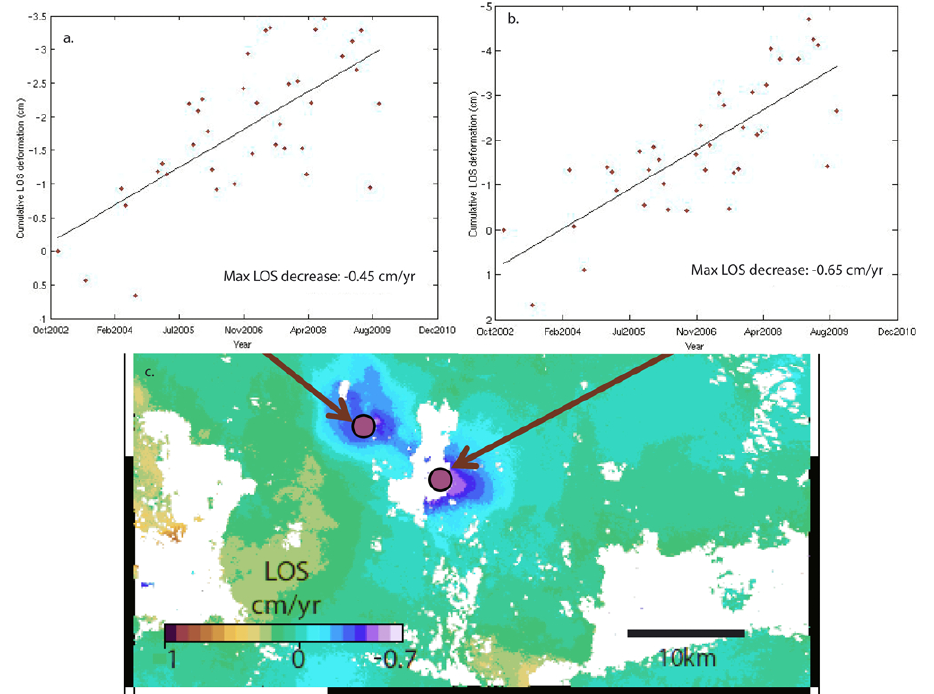
Figure 11. Unwrapped Envisat interferogram spanning 21 May 2005 to 8 August 2009, showing time series from two areas of LOS decrease (interpreted as uplift—( a , b )) and their locations in ( c ). The area with no information in the center of the uplifting zone corresponds to agricultural fields that are